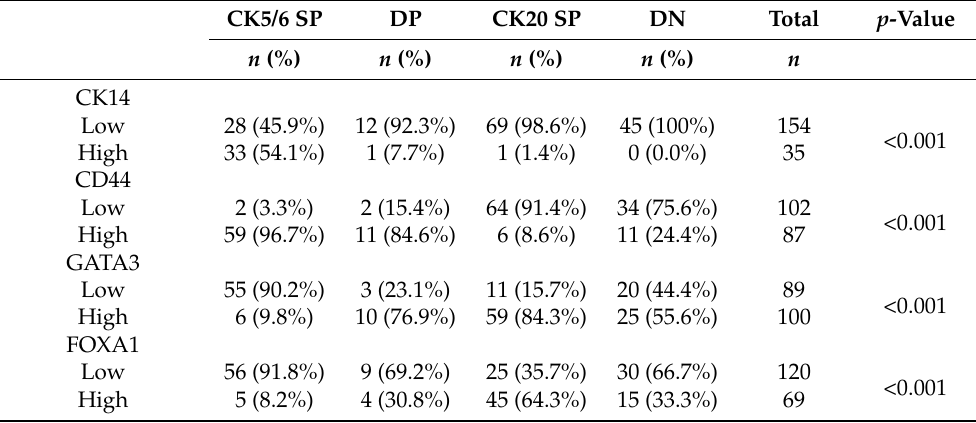
Table 5. Relationship between IHC defined subgroups with immunohistochemistry expression.